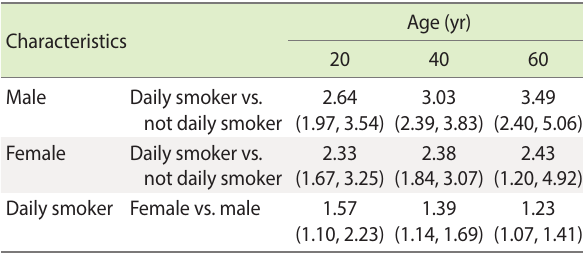
Values are presented as number (%) or mean±standard deviation. 1 Chi-square test.